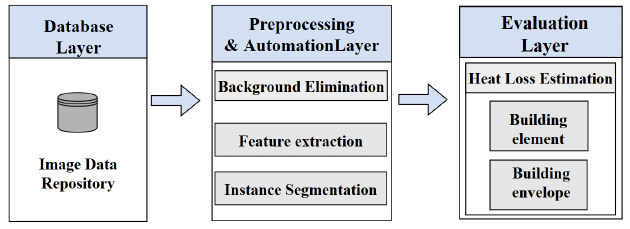
Figure 2. Data-driven approach for thermal performance [4].